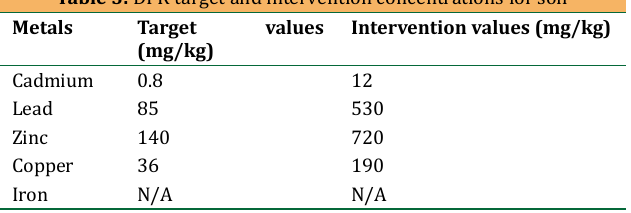
Table 3: DPR target and intervention concentrations for soil